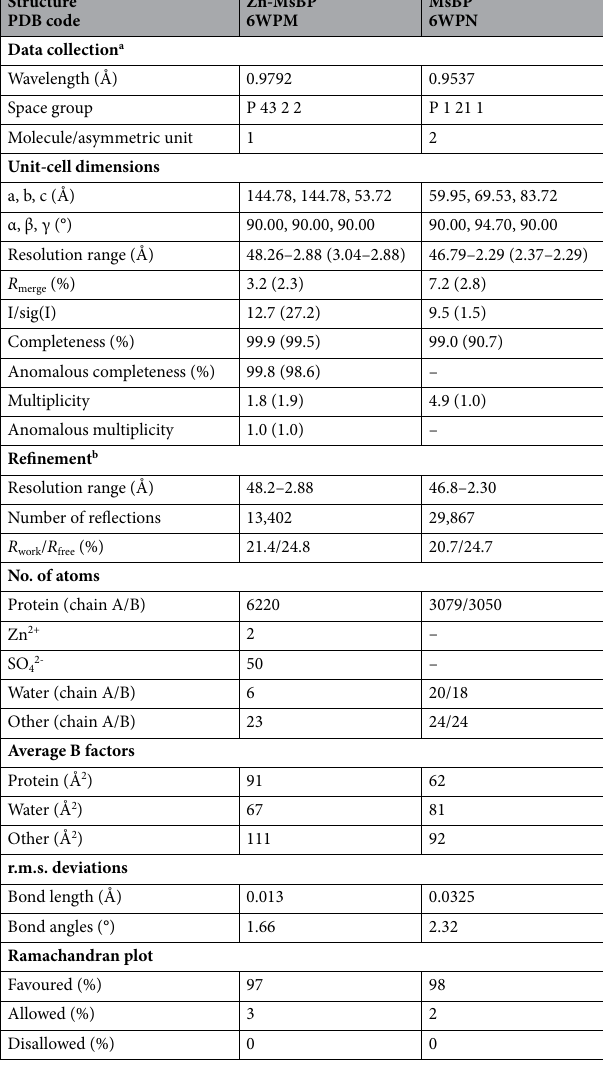
Table 2. X-ray data collection and refinement statistics. a Values in the parentheses denote the highest resolution shell. R free was calculated using a test set comprising 5% of the data. b Calculated using the MOLPROBITY program 72